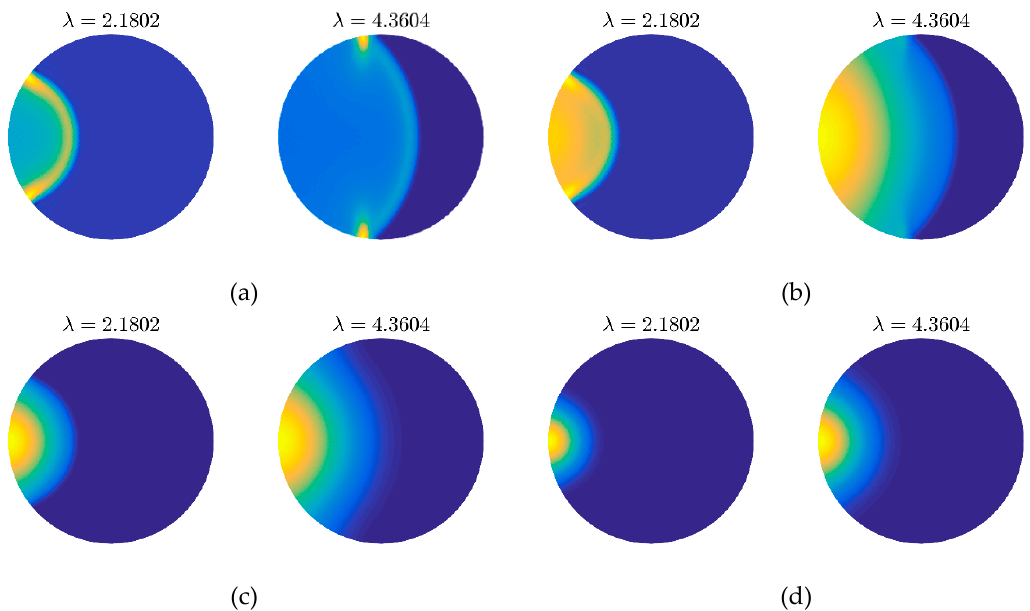
Figure 8. Thermal behaviors (snapshots) obtained by mesh grid in Figure 6b with di ff erent λ T : ( a ) wavy behavior λ T = 0; ( b ) wavelike behavior λ T = 0.1; ( c ) di ff usive behavior λ T = 0.5; ( d ) over di ff usive